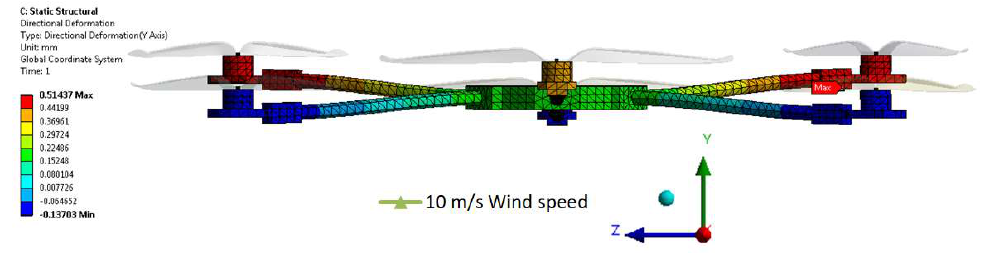
Figure 39. Maximum displacements on Y axis after 0.25s hover flight time.